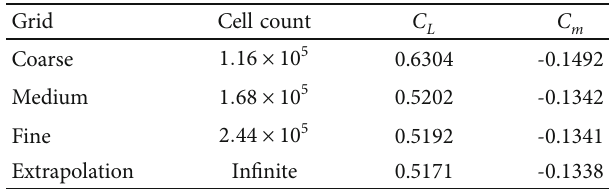
Table 1: Grid re fi nement study